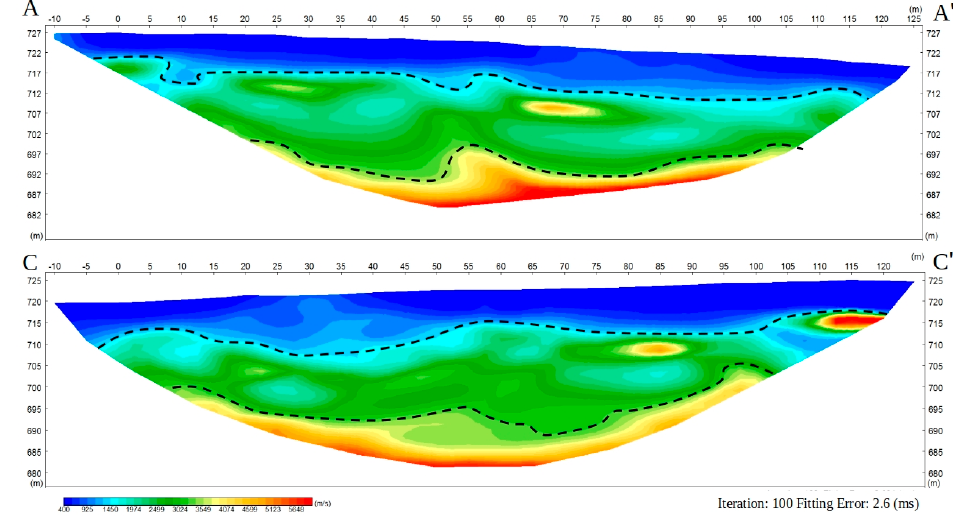
Figure 12. P-wave velocity tomographic models at the A - A’ and C - C’ seismic lines. The black dotted lines show the thickness of claystone (perched aquifer).